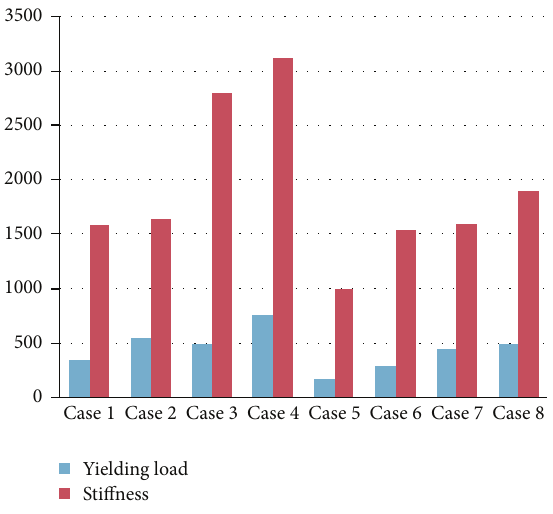
Figure 8: Yielding load and stiffness of NGH